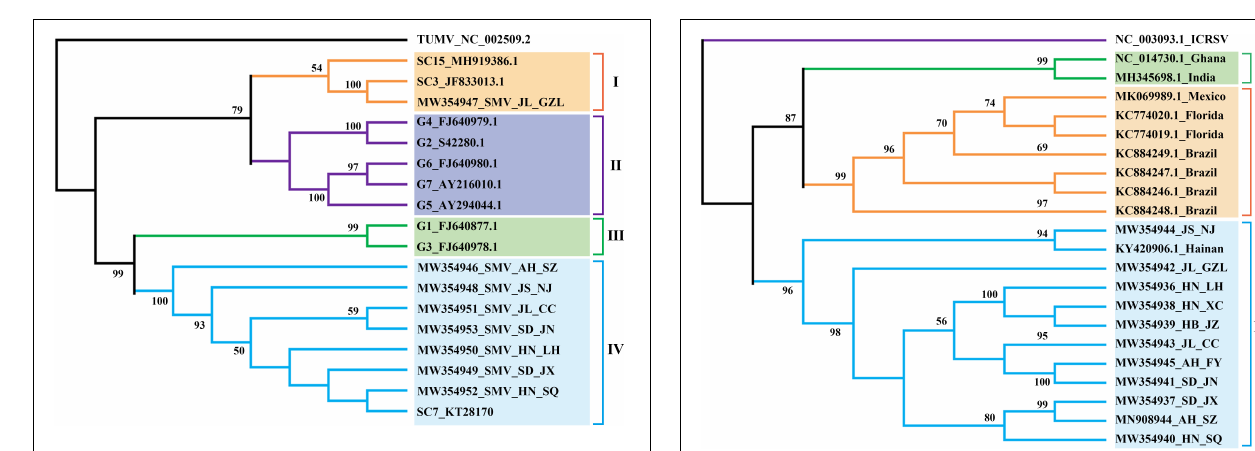
FIGURE 3 | ML-phylogenetic analysis of the complete genomes of cowpea mild mottle virus (CPMMV) isolates from different countries. The phylogenic tree was constructed using MEGAX. Near-complete genome sequences of CPMMV isolates were obtained from NCBI (https://www.ncbi.nlm.nih.gov/). The colored bars (blue, orange, green) indicate the different clades observed in the phylogenies. Blue, China; Orange, Brazil and Florida; Green, India, and